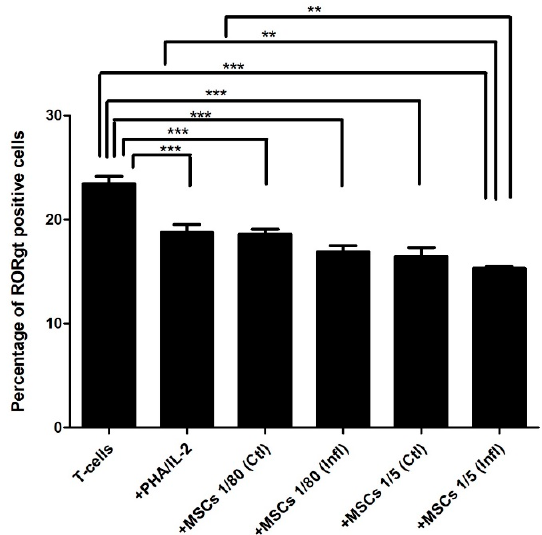
Figure 4. Influence of FSK-MSCs on ROR- γ t expression. FSK-MSCs were cocultured at a (1:5) or (1:80) cell ratio under normal and inflammatory conditions with either unactivated or PHA/IL-2- activated T cells as indicated. Levels of ROR- γ t expression were analyzed by flow cytometry. Data are expressed as the percentage of RORgt ± SEM-positive cells from seven independent experiments. ** p < 0.01, *** p < 0.01 versus